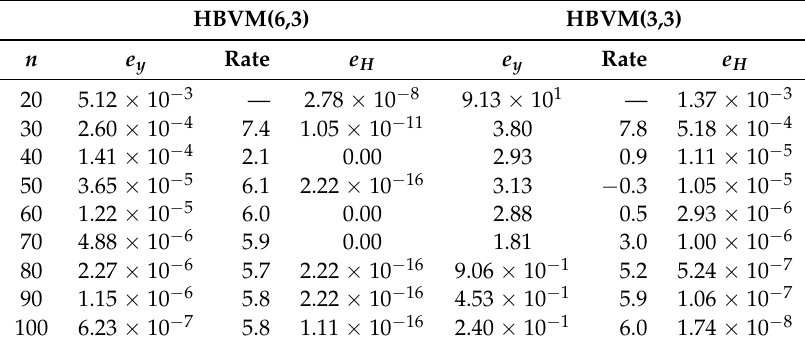
Table 2. Solution error e y ( y = ( q , p ) (cid:62) ) and Hamiltonian error e H when solving problem (46)–(47) with stepsize h = T / n